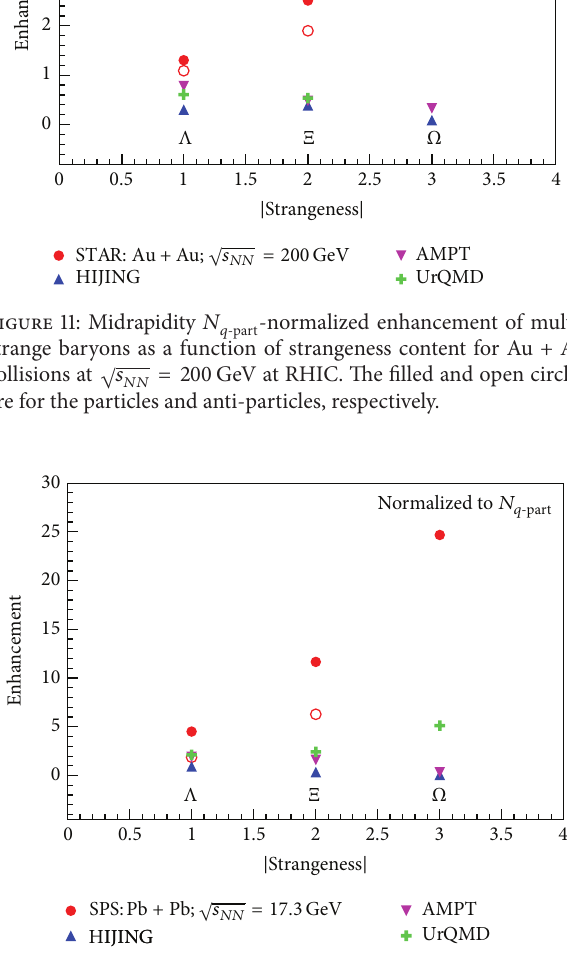
Figure 12: Midrapidity 𝑁 𝑞 -normalized enhancement of multi- -part strange baryons as a function of strangeness content for Pb + Pb collisions at √𝑠 𝑁𝑁 = 17.3 GeV at SPS. The filled and open circles are for the particles and the antiparticles,